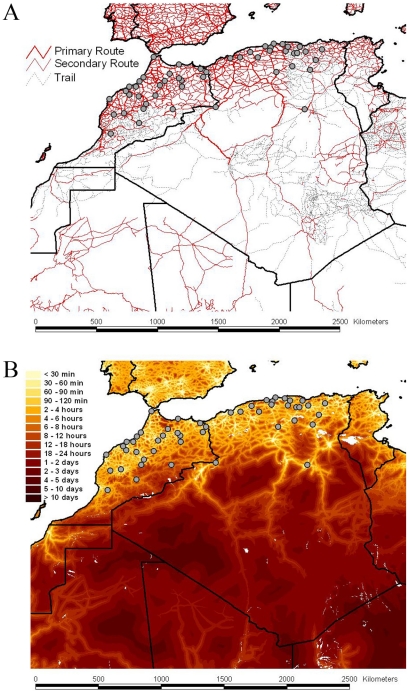
Road network, accessibility and sampling locations of RABV samples.The road network and the accessibility are shown in panels A and B, respectively The border between the countries is indicated by dark lines. Specific locations were unavailable for Tunisian samples. The color gradient indicates the estimated travel time to the nearest city of population greater than 50,000 people, with yellow at one extreme indicating low travel times (<30 min) and red at the other extreme indicating long travel times (>10 days). The data are available for download from http://gem.jrc.ec.europa.eu/.